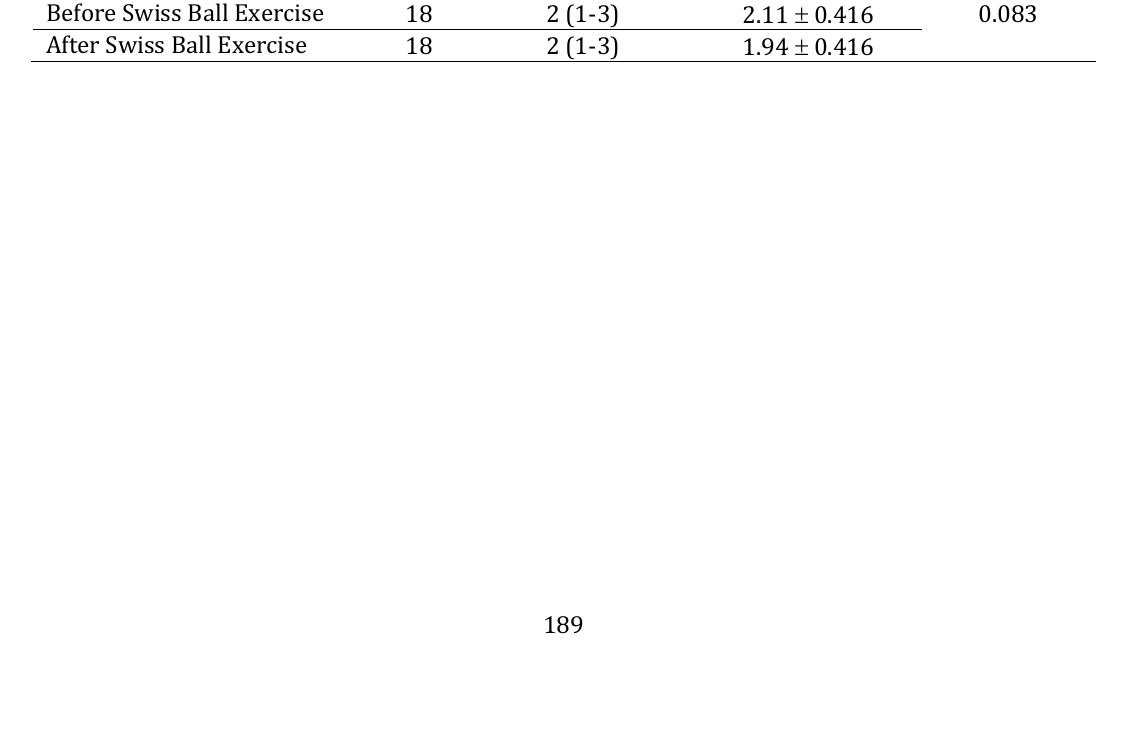
Wilcoxon Test Results with Time Up and Go Test in Control Group